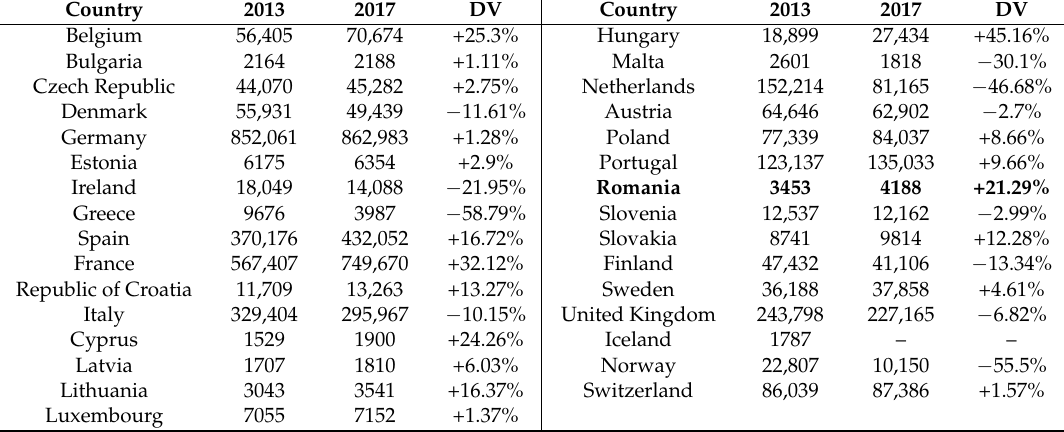
Table 1. The distribution of non-fatal accidents in European Union (EU) member countries [1].